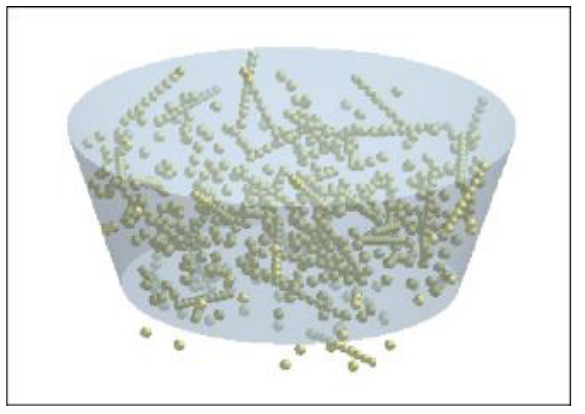
Figure 3. Pellet